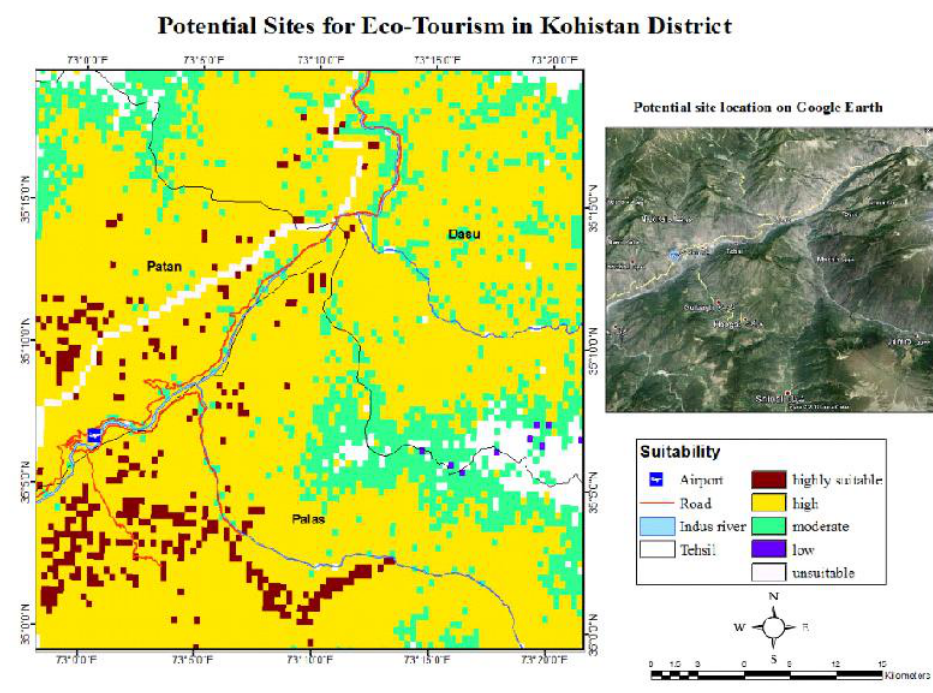
Fig. 5: Potential Sites for Eco